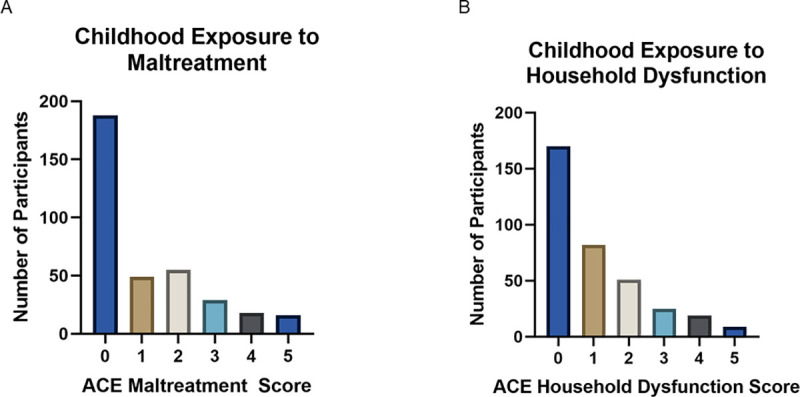
Frequencies of reported ACE scores.Observed frequencies of ACE-Maltreatment (A) and ACE-Family Dysfunction scores within the sample. Each score represents the total number of types of maltreatment or family dysfunction reported by the individual, rather than cumulative occurrences.